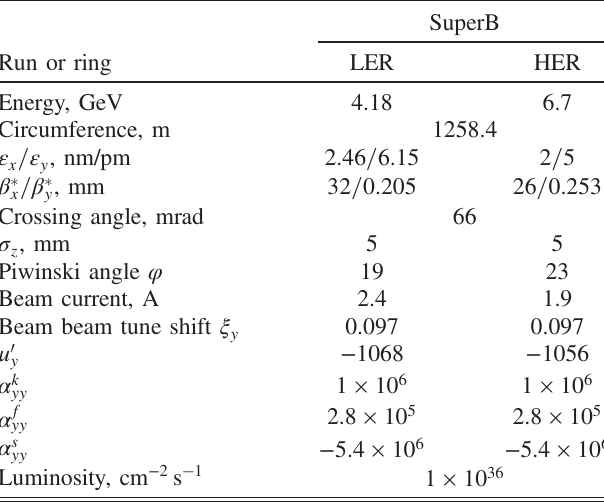
TABLE II. Parameters of SuperB.